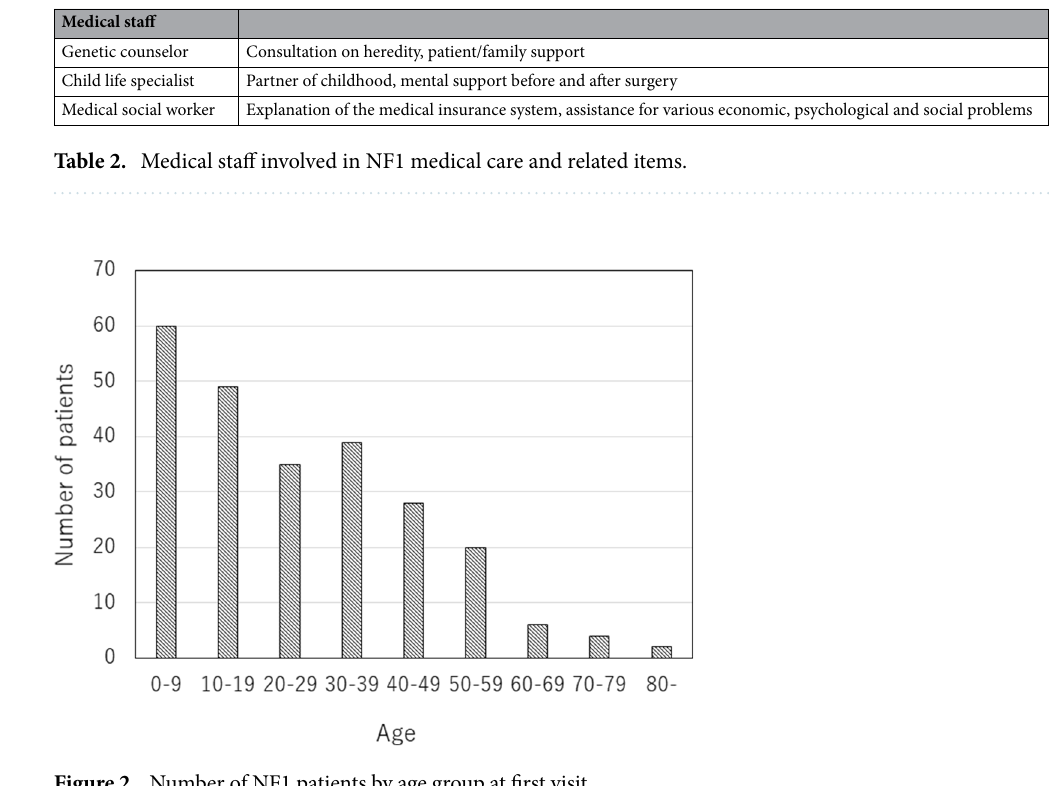
Figure 2. Number of NF1 patients by age group at first